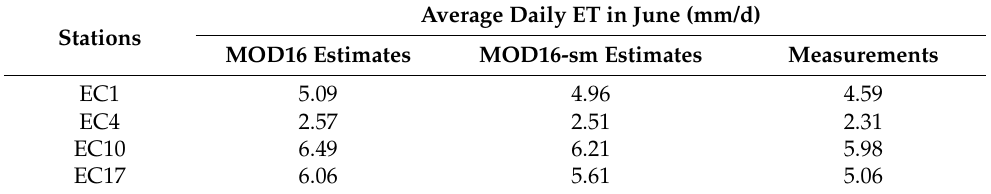
Table 2. Daily average ET comparisons on monthly scale.